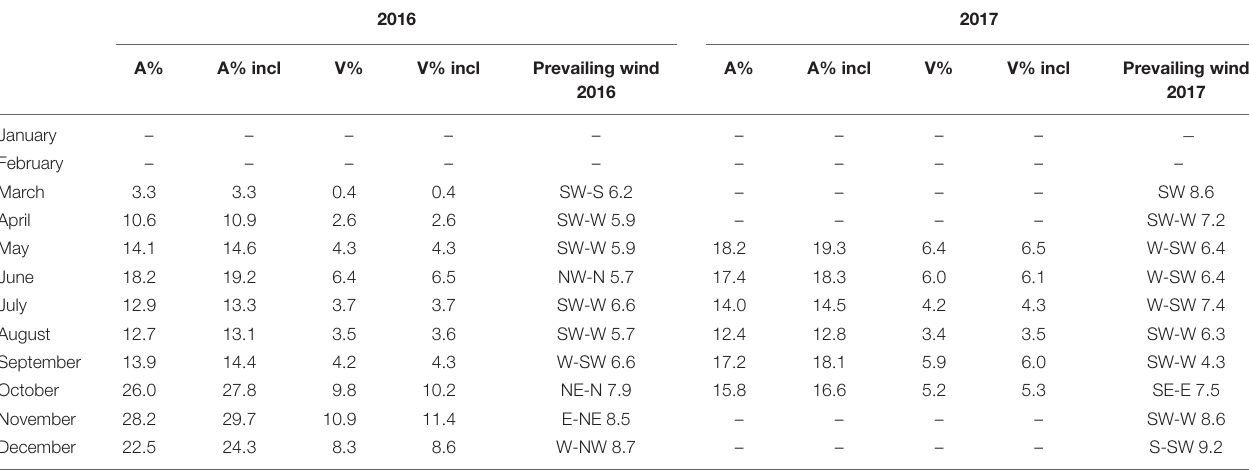
FIGURE 4 | Variability of the hypoxic depth and salinity at the hypoxic depth based on individual profiles acquired at the Keri station in 2016 (A) and 2017 (B) . Dashed lines show the linear temporal trend of salinity at the hypoxic depth from May to October. In both years, the trend was significant with R 2 = 0.68 ( p < 0.05) in 2016 and R 2 = 0.25 ( p < 0.05) in 2017. TABLE 2 | Monthly averages of the bottom area and volume (percent of total area/volume) for the leveled and the inclined border of the hypoxic layer in 2016 and 2017; “incl” stands for the inclined layer, “A” for area and “V” for